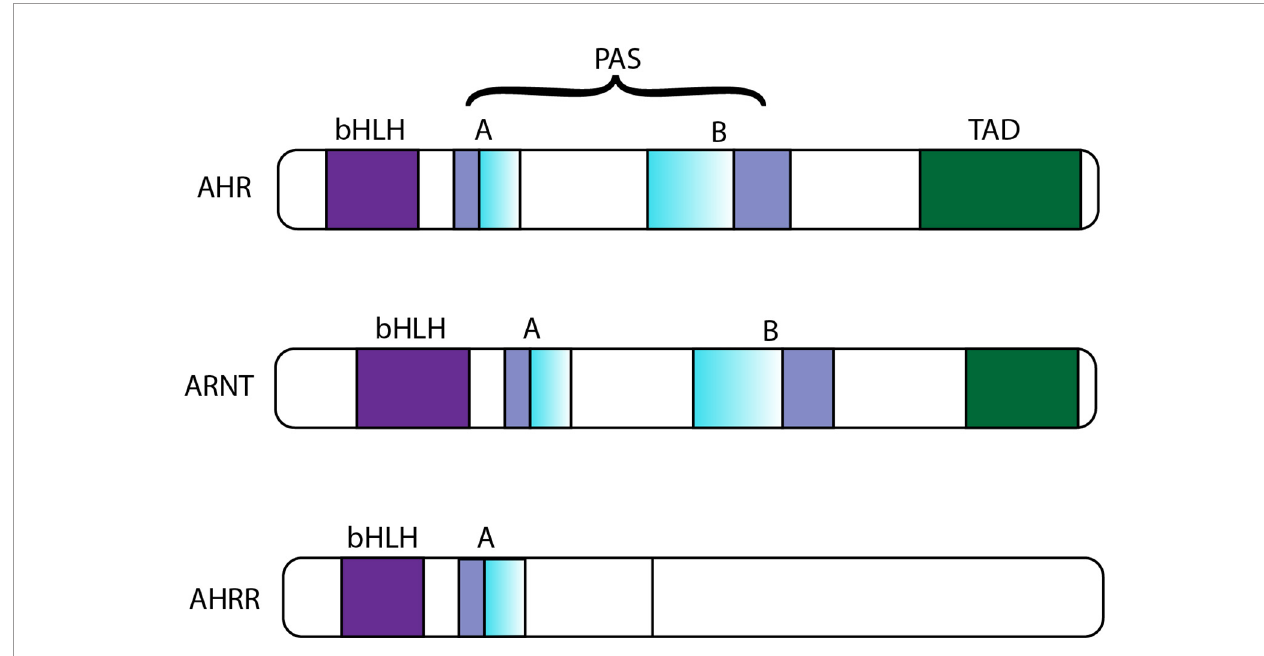
FIGURE 2 | Sequence comparison of AHR, ARNT and AHRR. bHLH, basic helix-loop-helix; PAS, PER-ARNT-SIM; TAD, transcriptional activation domain; AHR, aromatic hydrocarbon receptor; ARNT, aromatic hydrocarbon receptor nuclear translocation; AHRR, aryl hydrocarbon receptor